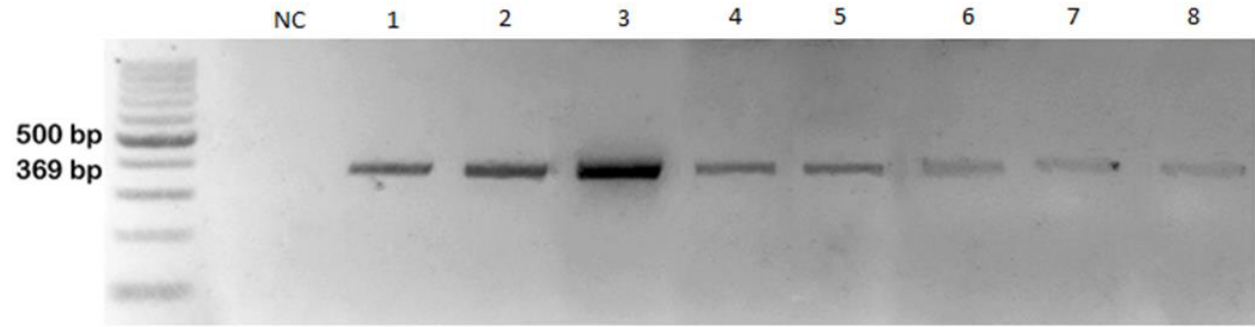
Figure 4. Detection of Goose Reovirus (GRV) by RT-PCR; from left DNA Marker 1 (A&A, Poland, 100–1000 bp), NC—negative control, 1—liver, 2—spleen, 3—joints, 4—tendon, 5—tendon sheath, 6—heart, 7—kidney, 8—intestines; product size 369 bp.